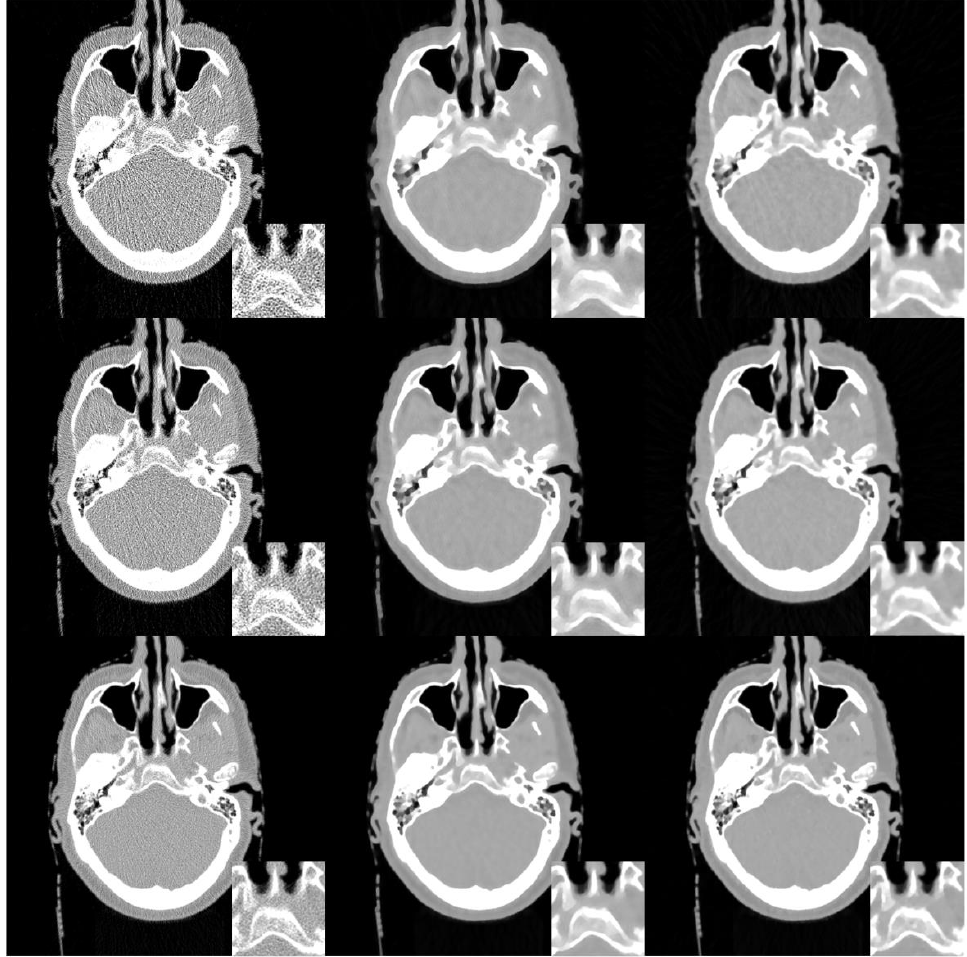
Figure 3. Images reconstructed by the FBP (left column), SIR-TV (middle column), and structure tensor total variation SIR-STV 1 (right column) methods from noisy projections with incident photon numbers 5 × 10 3 (the first row), 1 × 10 4 (the second row), and 5 × 10 4 (the third row). The display window is [–1000, 667] HU.